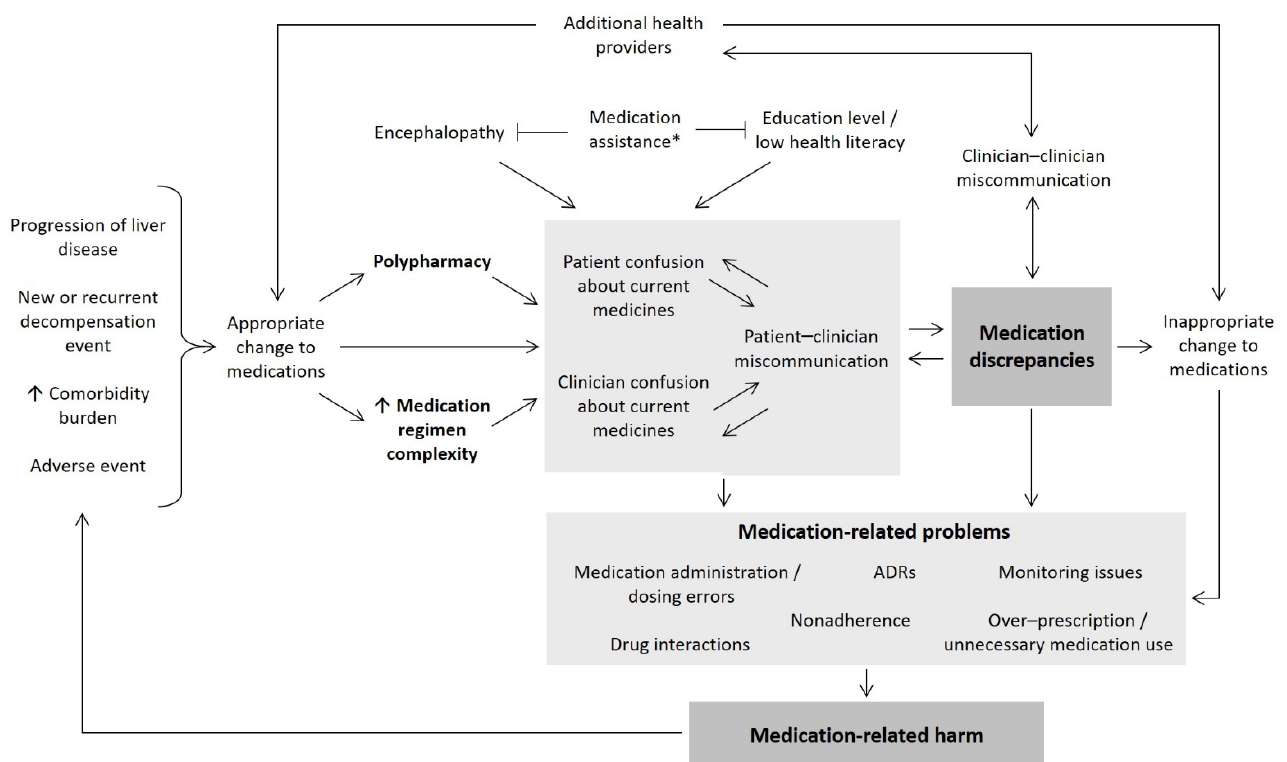
Figure 3. The relationship between medication discrepancies and medication-related harm in people with decompensated cirrhosis. * Medication assistance including (but not limited to) a pharmacy packing aide or assistance from a family member/caregiver. Abbreviation: ADRs, adverse drug reactions.